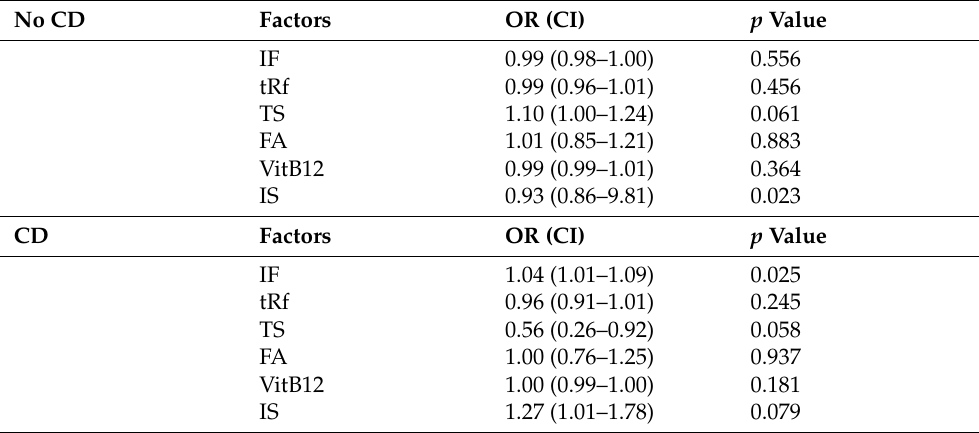
Table 4. Anemia-related